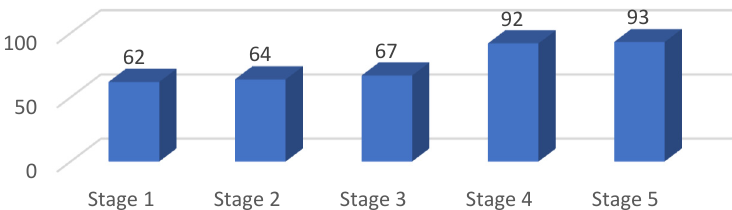
Figure 9. Difference between the current and expected strategies. Source: edited by authors.